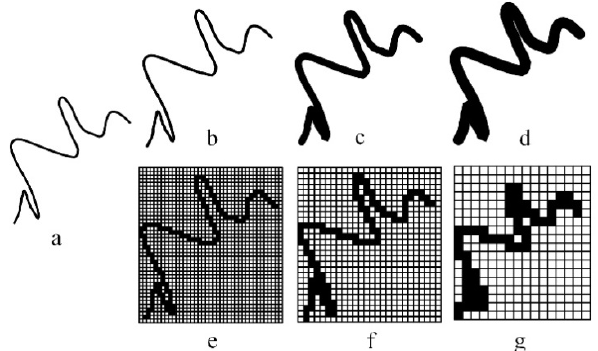
Figure 1. Detecting the LoD of a curve using the progressive increment method. ( a ) A curve with bends. ( b – d ) Curve representation when the symbol width is respectively 1m, 2m and 3.5m. ( e – g ) Rasterizing results of curves, respectively, at 1m, 2m and 3.5m.